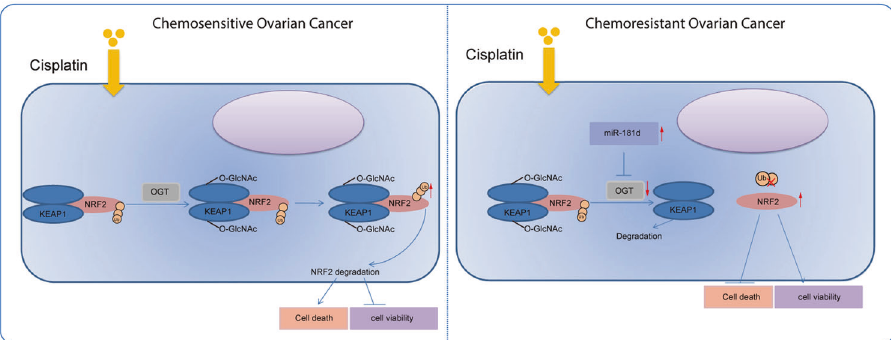
Fig. 8 Schematic diagram of the mechanism by which miR-181d affects OC chemoresistance via the OGT/KEAP1/NRF2 axis. miR-181d directly targets OGT and inhibits the expression of OGT, thereby inhibiting the glycosylation of KEAP1, reducing the ubiquitination, and degradation of NRF2 and promoting the expression of NRF2. By this mechanism, the viability of OC cells is promoted while cell apoptosis is suppressed, ultimately inducing the chemoresistance of